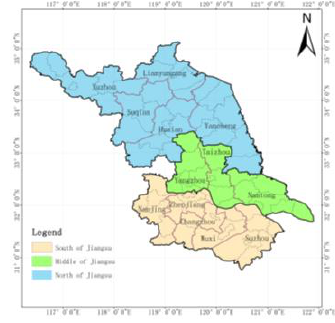
Figure 1. Location of Jiangsu